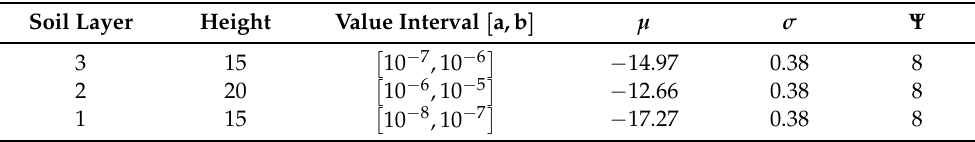
Figure 4. Density function of the Log-Gaussian distribution with probability (hatched area) of permeability values in the interval [ a,b ] = Table 1. Gaussian random field parameters for the three soil